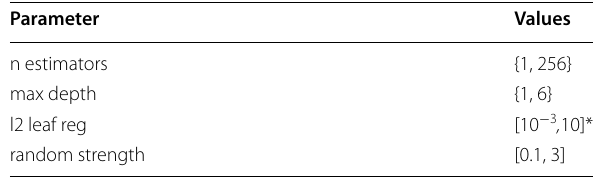
Table 1 Parameter space searched by the Optuna parameter search for the baseline CatBoost